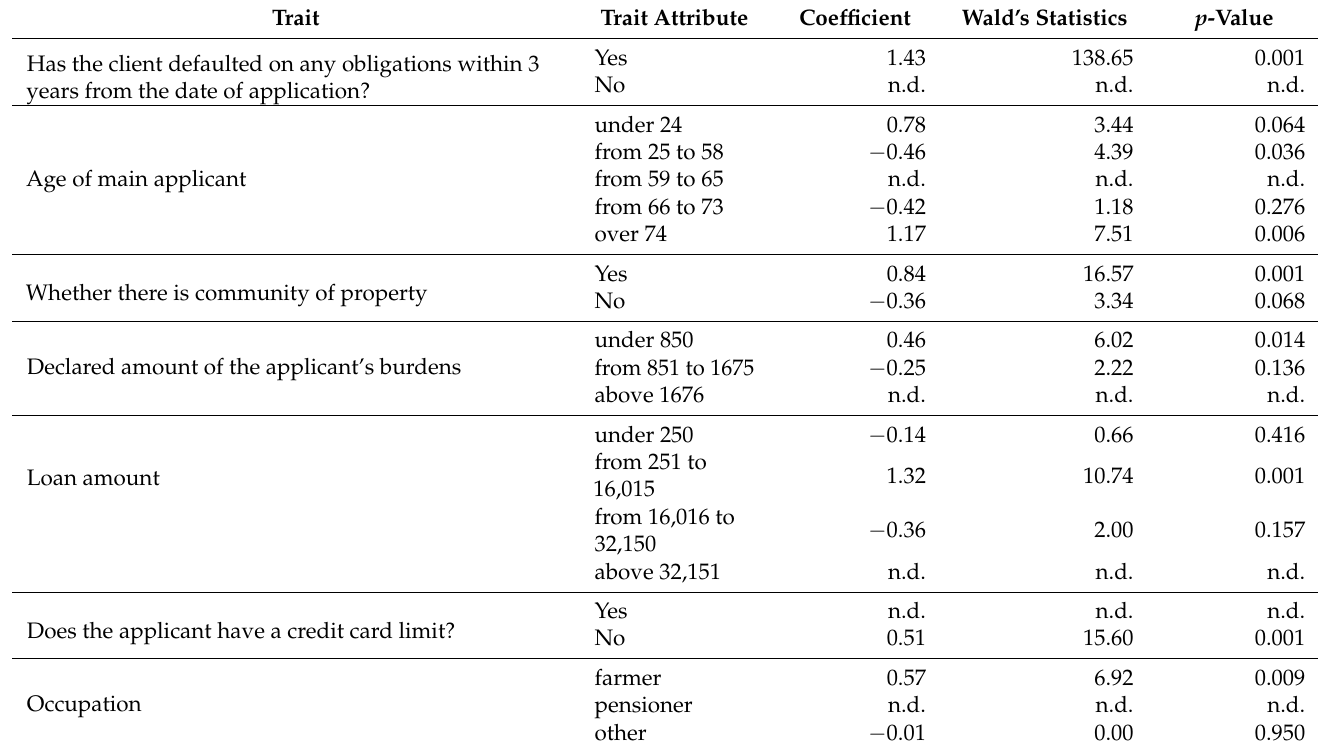
Table 4. Credit risk logit model for the entire study